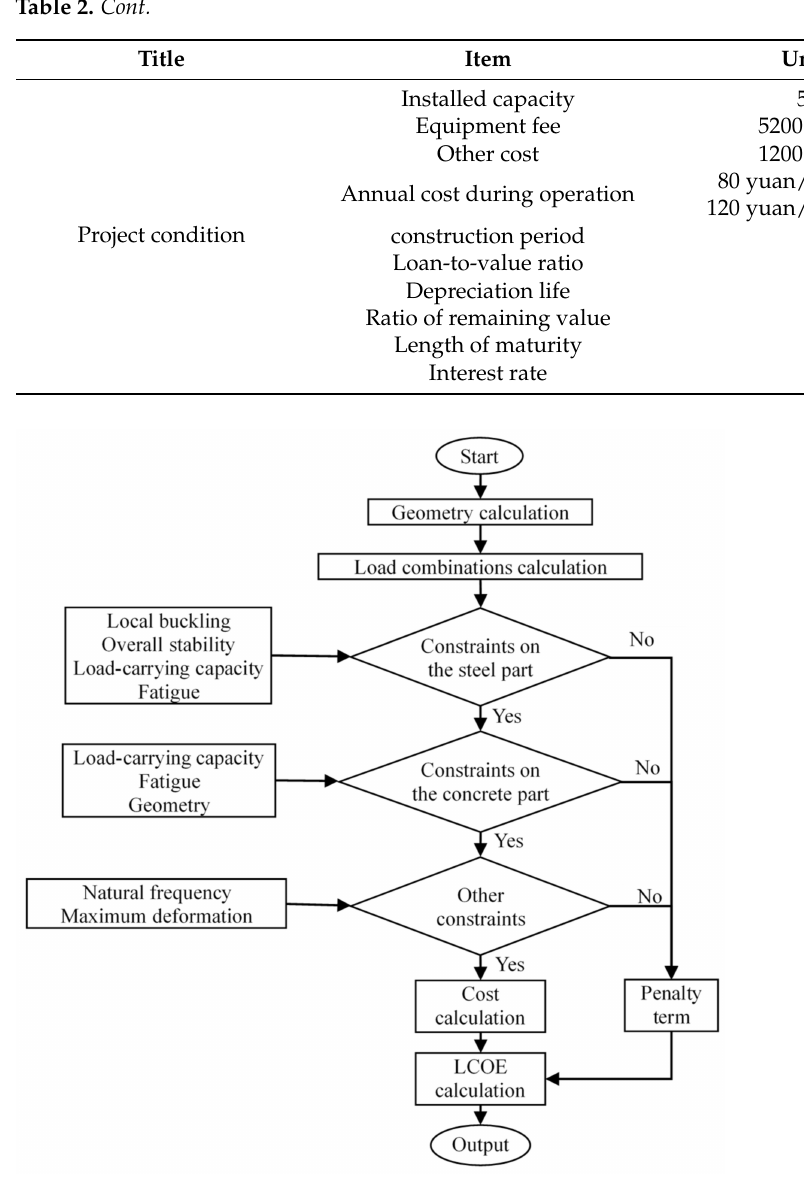
Figure 3. Flow chart of cost evaluation for the PCSH